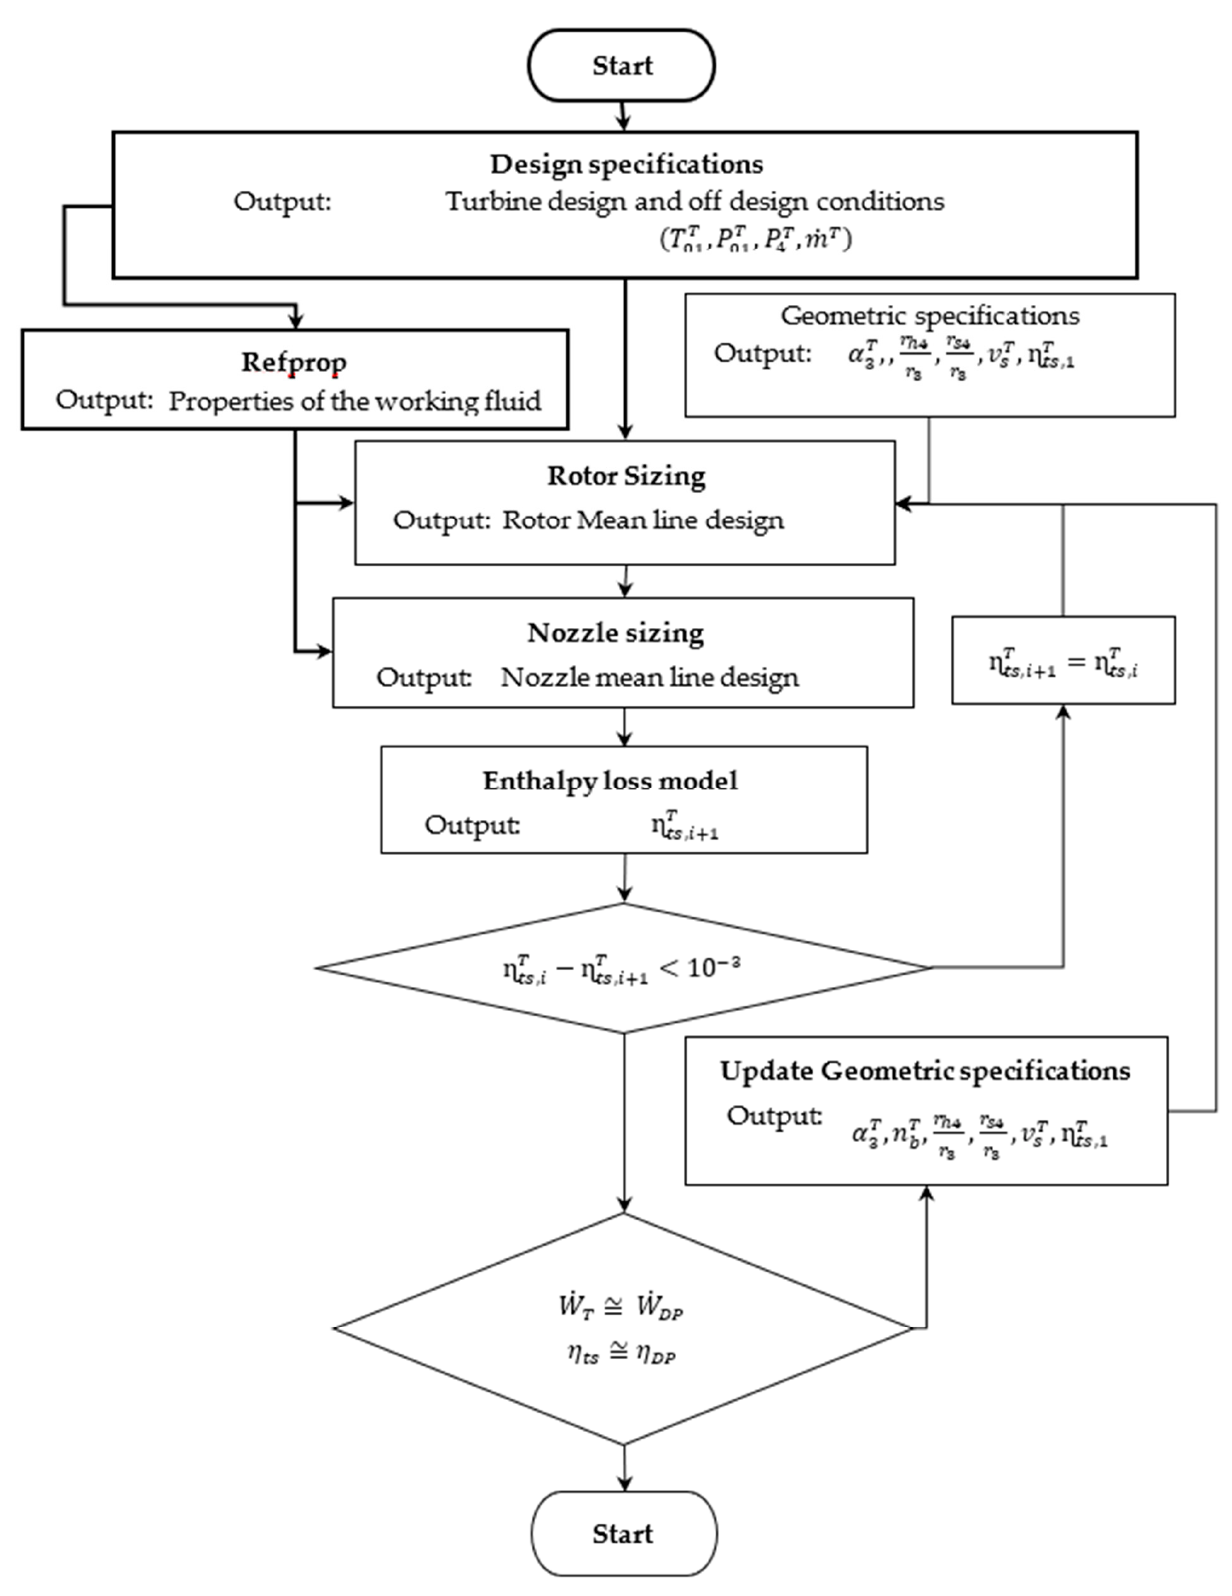
Figure 3. Radial turbine design flow diagram.